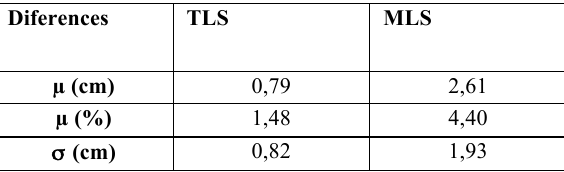
Figure 6 Segmentation of an intensity image created from MLS data: watershed segmentation results (top); superimposition of segmented image and original image (bottom).